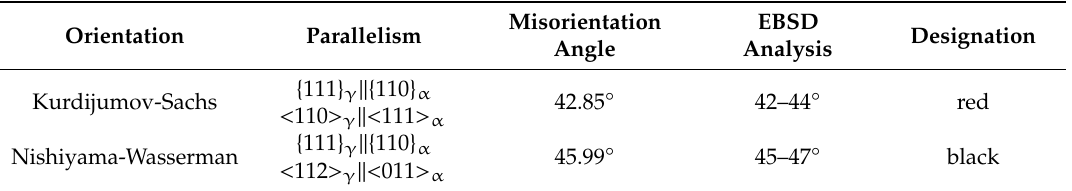
Figure 7. ( a ) Inverse Pole Figure (IPF) Map of the FZ. ( b ) Phase Distribution Map of the FZ. ( c ) Phase distribution map with indicated boundaries of N-W (marked in black) and K-S (marked in red) orientations. Ferrite-white, austenite-gray. ( d ) Misorientation angles distribution of the FZ. Table 4. Orientation relationships between ferrite and austenite [24,25] along with the range of misorientation angles used in the EBSD